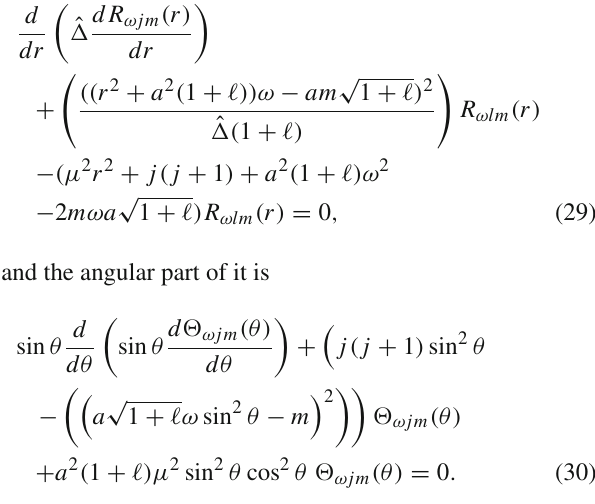
Fig. 4 The cross-section of the event horizon (outer red line), SLS (outer blue dotted line), and ergoregion of NC Kerr-like black